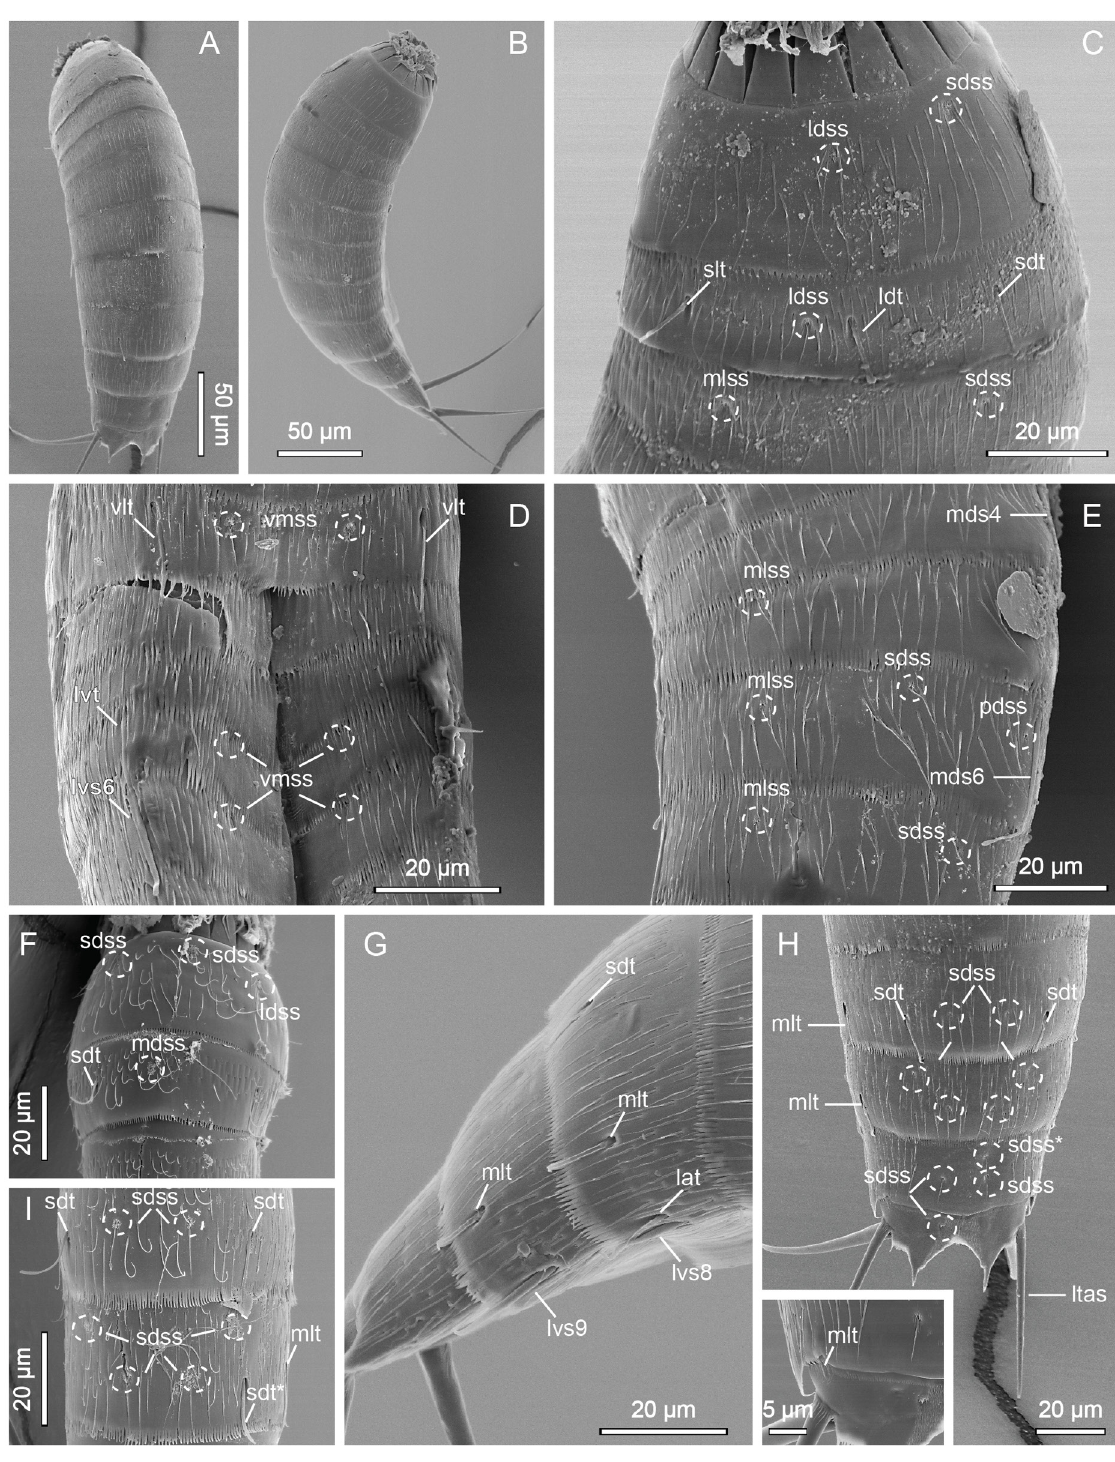
Fig. 7. Scanning electron micrographs showing overviews and details of Echinoderes landersi sp. nov. A . Dorsal overview. B . Lateral overview. C . Segments 1 to 3, lateral view. D . Segments 2 to 6, ventral view. E . Segments 4 to 7, dorsolateral view. F . Segments 1 to 3 of female with inconsistent tube pattern, dorsal view. G . Segments 8 to 10, lateral view. H . Segments 8 to 11, dorsal view, with inset showing close-up of midlateral tube on segment 10. I . Segments 8 to 9 of female with inconsistent tube pattern, dorsal view. Abbreviations: see Material